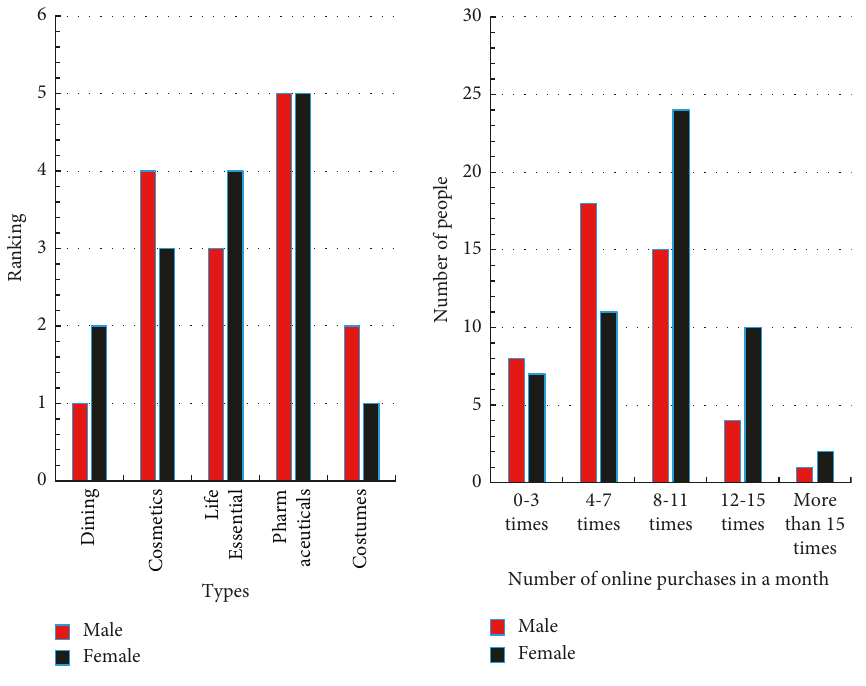
Figure 8: Online shopping of respondents. Table 3: Amount spent on online shopping in one month by respondents of different age groups.